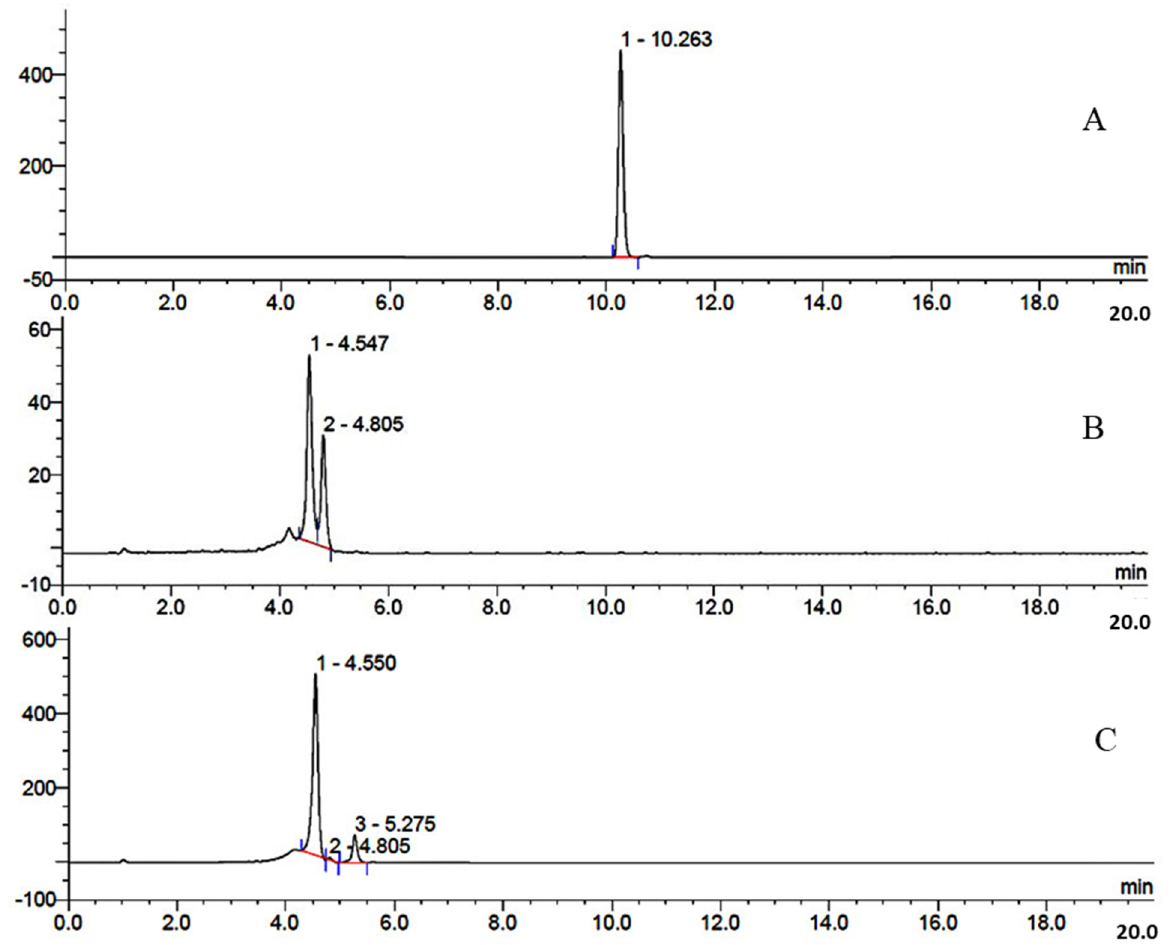
Figure 2. Radio-HPLC analysis of the reaction mixture: ( A ) radiofluorination of 4 (preparation of 5 ); ( B ) hydrolysis of 5 with 1.5 N HCl in 50% MeOH; ( C ) hydrolysis of 5 with 0.5 N HCl in 50% MeOH. HPLC conditions: column: XBridge ® C18 5 µ m, 150 × 4.6 mm (Waters, Millford, CT, USA); gradient: 0–2 min: 2% MeCN (0.1% TFA), 2–13 min: 2–90% MeCN (0.1% TFA); flow rate: 2.0 mL/min; R t of 5 : 10.3 min; R t of 6- L -[ 18 F]FMT: 4.6 min.